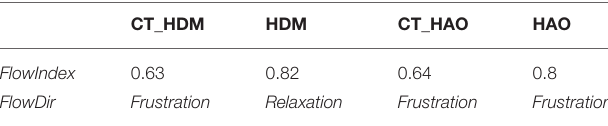
TABLE 5 | FlowIndex and FlowDir for the 5-min calibration and 5-min closed-loop tasks for the HDM and HAO